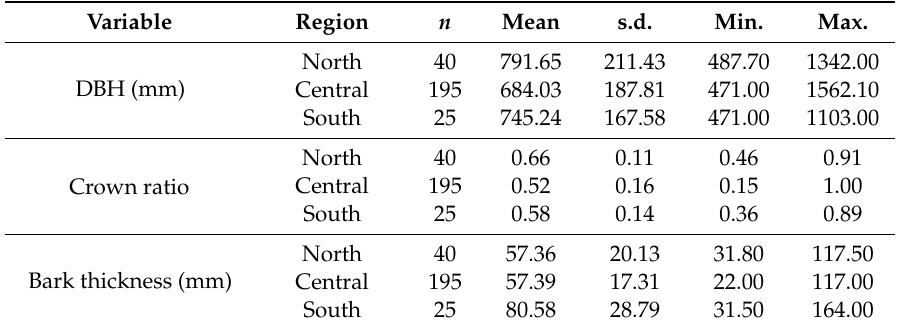
Table 6. Summary data for redwood trees in the northern, central, and southern parts of redwood’s natural range.